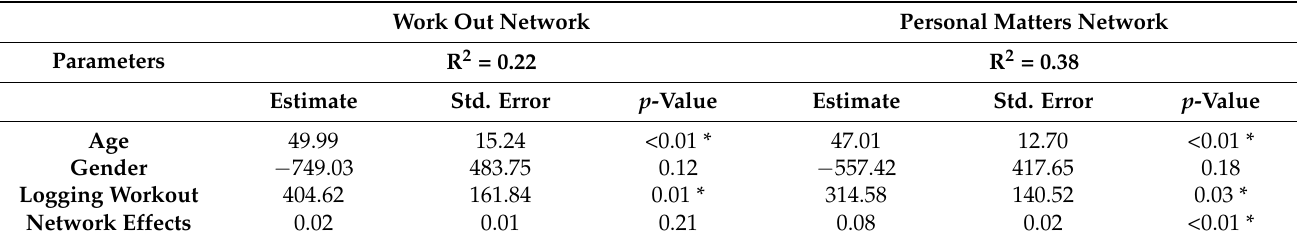
Table 1. Linear network autocorrelation models for MET minutes per week.